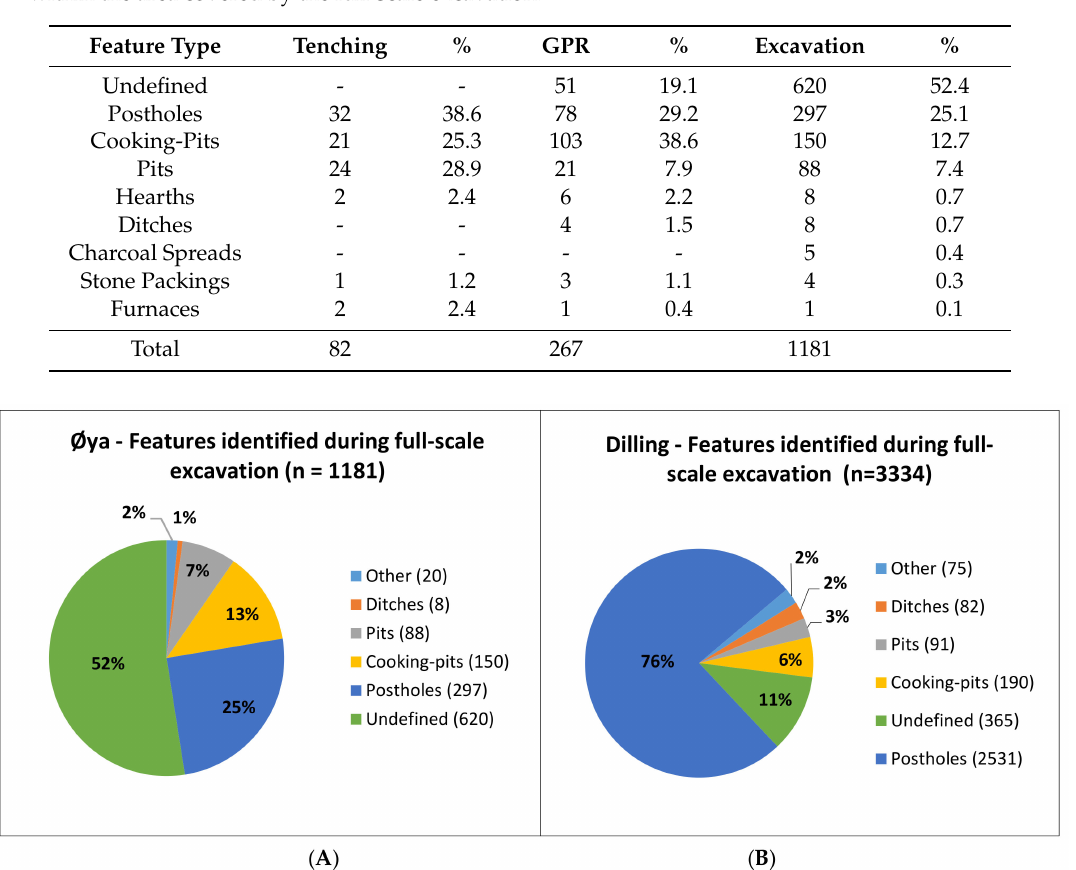
Figure 9. ( A ) Diagram showing the types of features identified through topsoil stripping at Øya. Of the identified and interpreted features, postholes and cooking-pits comprise 38% of the total number of features. At Øya the “undefined” category is the largest. ( B ) Diagram showing the types of features identified through topsoil stripping at Dilling. Of the identified and interpreted features, postholes and cooking-pits comprise over 80% of the total number of